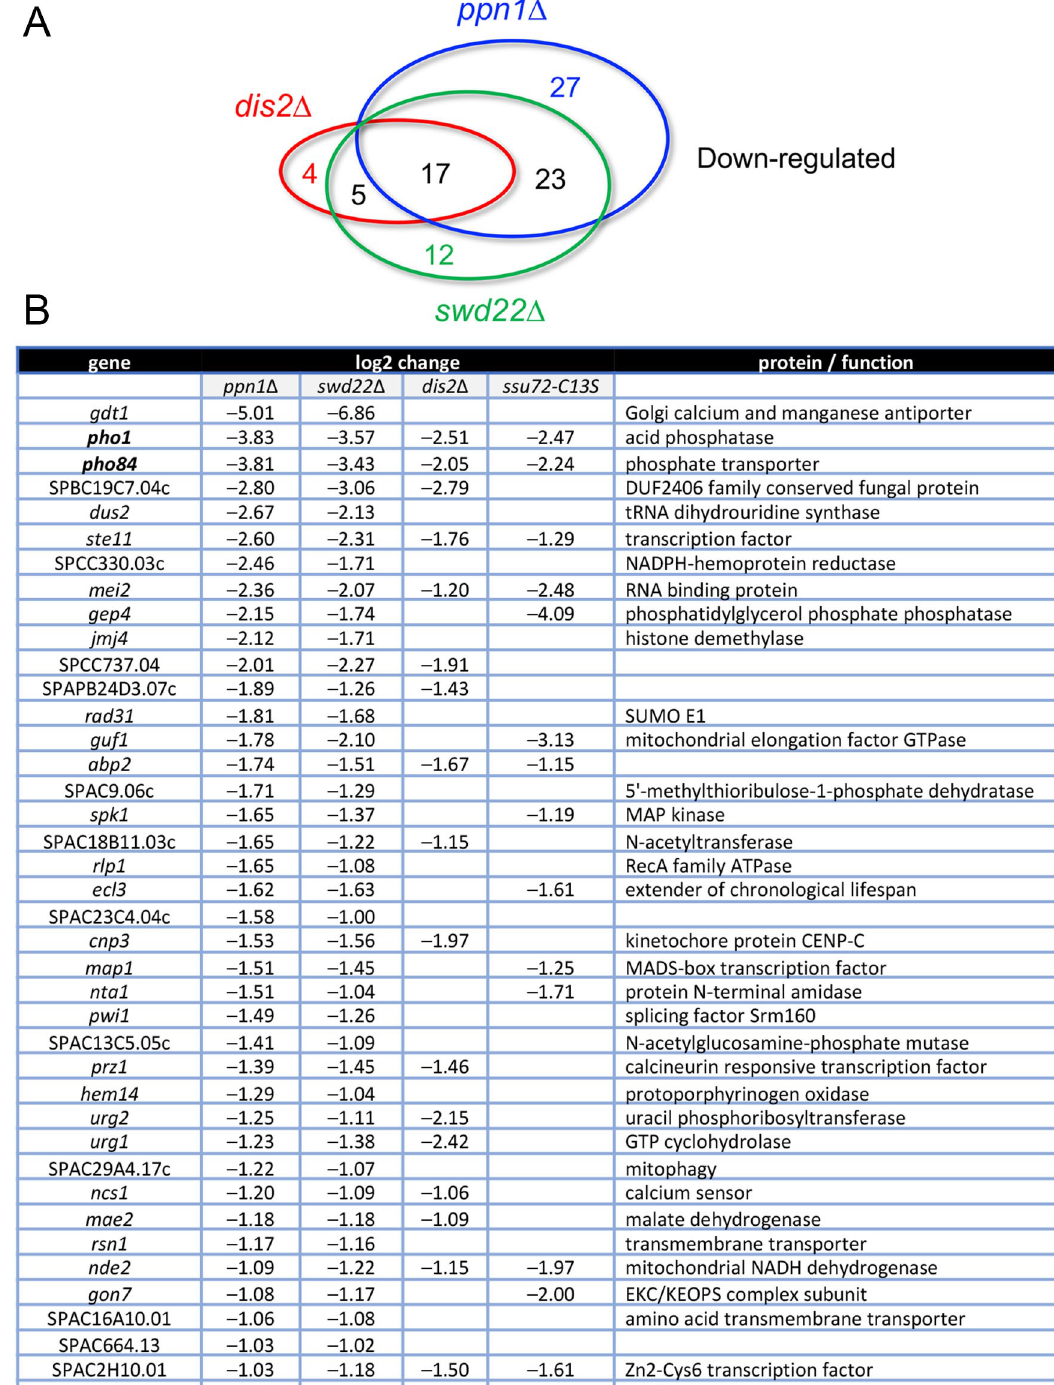
Fig 3. Coding genes down-regulated in DPS mutants. (A) Venn diagram depicting numbers of overlapping and non-overlapping down-regulated protein-coding genes. (B) List of 40 protein-coding genes that were coordinately down-regulated at least 2-fold in ppn1 Δ and swd22 Δ cells, 17 of which were also down-regulated in dis2 Δ cells and 14 of which were down-regulated in s su72-C13S cells. The log2 fold changes versus wild-type are shown.